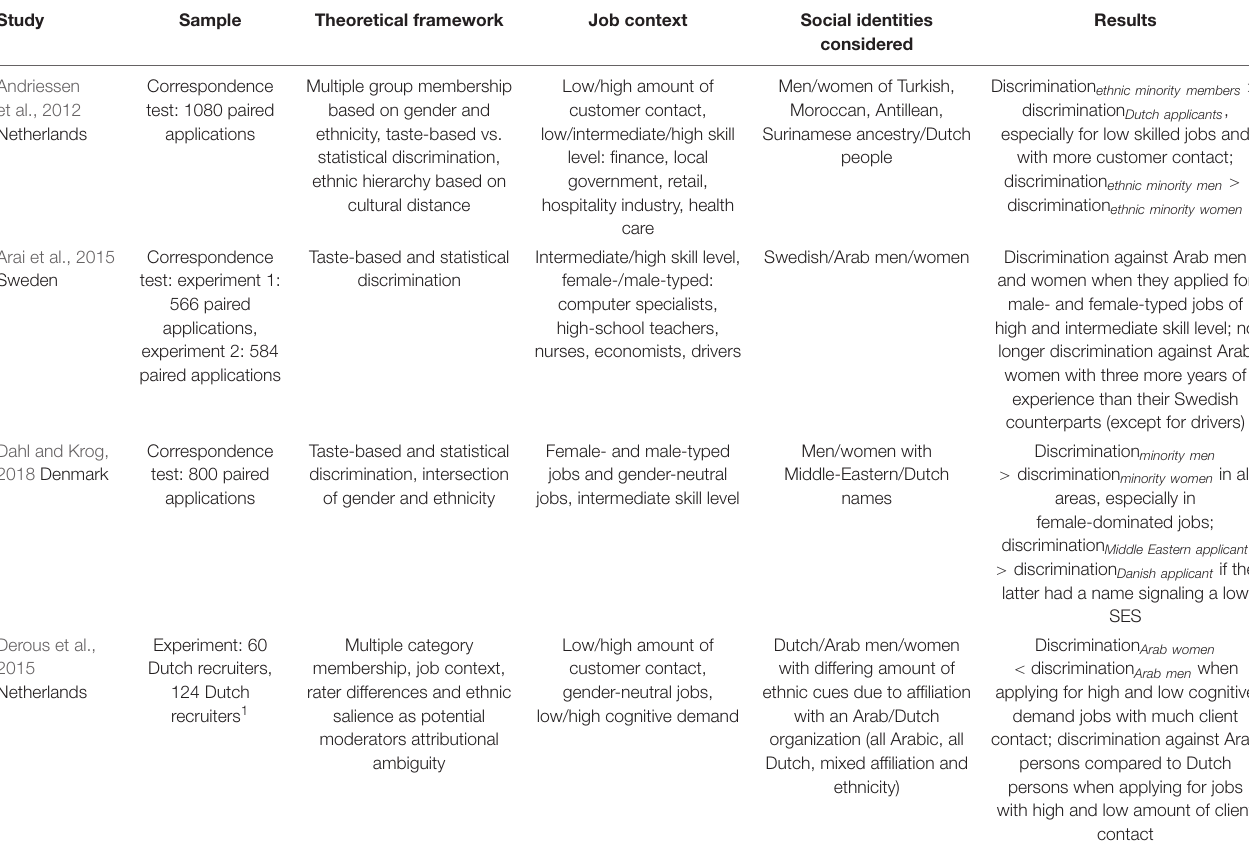
TABLE 3 | Overview of European social psychological studies on labor market discrimination based on the subordinate male target